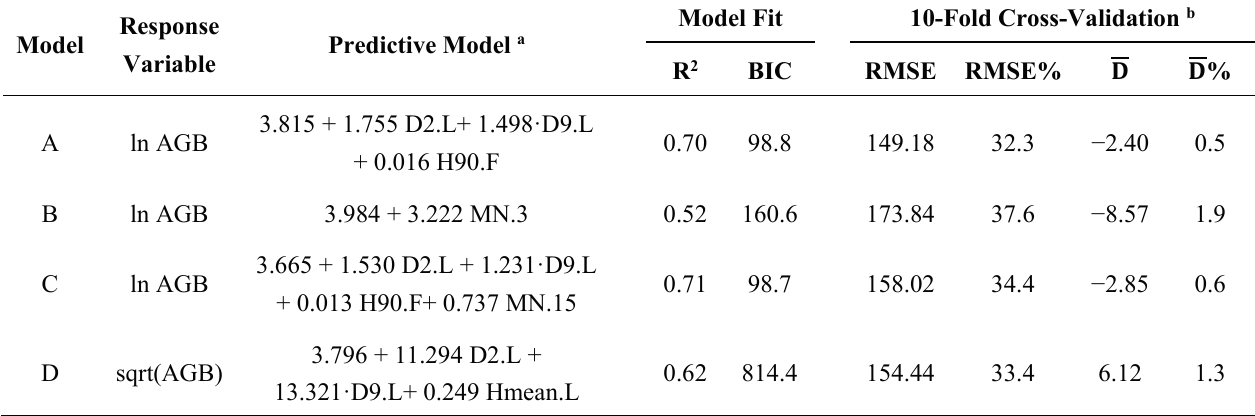
Table 4. Summary of regression models for aboveground biomass (AGB) using ALS